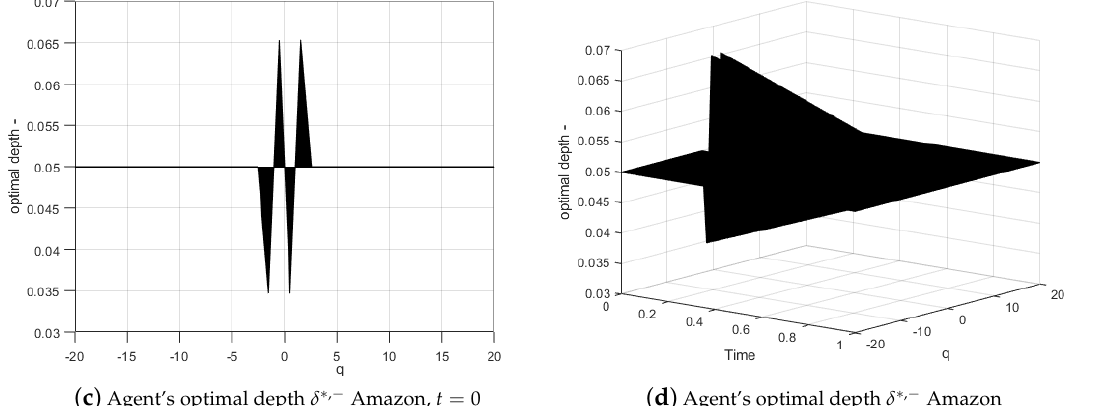
Figure 9. Agent’s optimal depth for selling LOs and agent’s optimal depth for buying LOs for Amazon stocks. ( a ) agent’s optimal depth calculated with Equation (94), using the parameters in Table 9 at time zero. ( b ) agent’s optimal depth calculated with Equation (94), using the parameters in Table 9 in 3 dimensions. ( c ) agent’s optimal depth calculated with Equation (95), using the parameters in Table 9 at time zero. ( d ) agent’s optimal depth calculated with Equation (95), using the parameters in Table 9 in 3